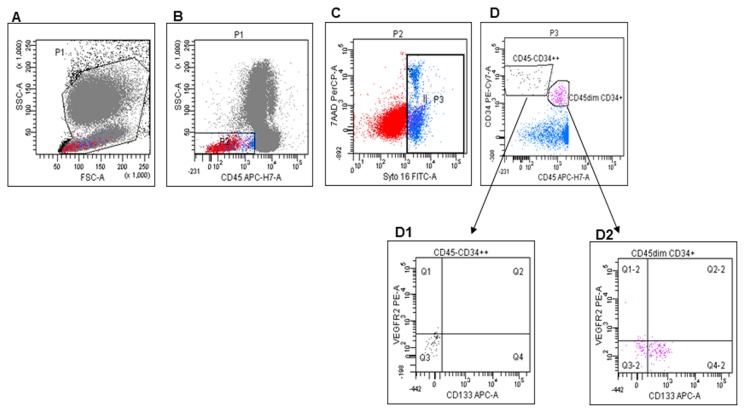
Progenitor cell evaluation by flow cytometry.A: Gate used to exclude cell fragments and debris. B: Gate made to include CD45- and CD45dim cells. C: Gate on Syto16+ 7AAD+ cells. D: Identification of 2 different populations: CD45-CD34+ + and CD133-VEGFR2- (D1), and CD45dimCD34+ and CD133+ cells (D2).